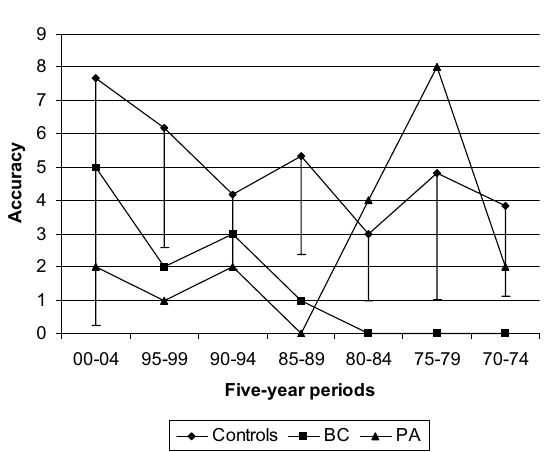
Fig. 2. Performance scores obtained by BC, PA and a group of 6 nor- mal controls on Crovitz’s procedure for assessing retrograde autobi- ographical memory as a function of the five-year periods